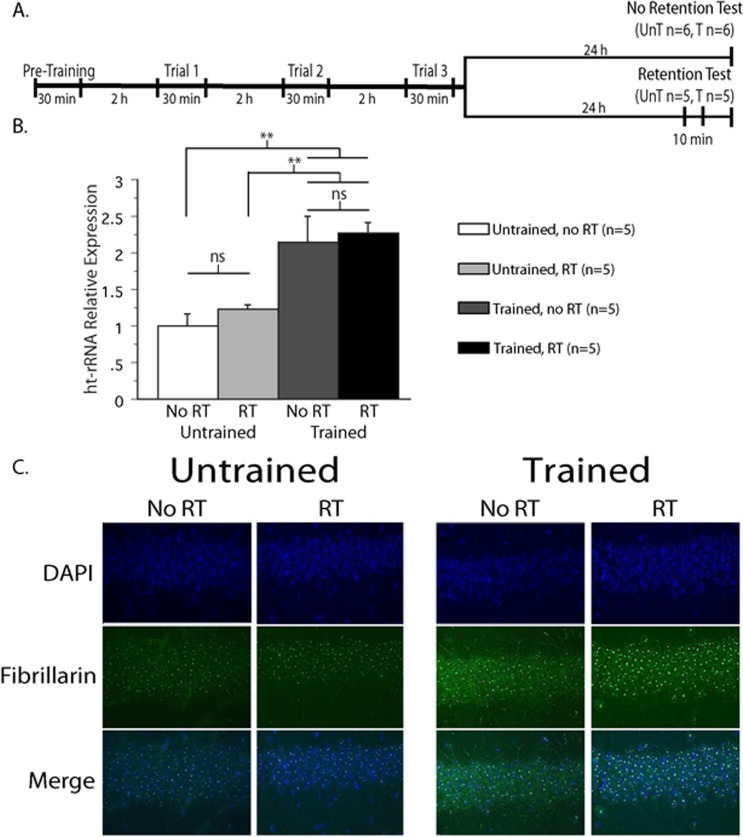
Elevated expression of rRNA is maintained at least 24 h after training.A) Timeline of the training protocol. Note that half of the animals were given a retention test, while the other half were not. All animals were euthanized 24 h after training. B) Expression of ht-rRNA precursor 24 h after APA exposure. 45S ht-rRNA expression is elevated 24 h after training compared to Untrained animals. The retention test did not significantly affect rRNA expression. C) Immunohistochemistry of dorsal CA1 fixed 24 h after training with or without a retention test. Increased fibrillarin staining in the Trained animals indicates an active nucleolus. **p<0.01.